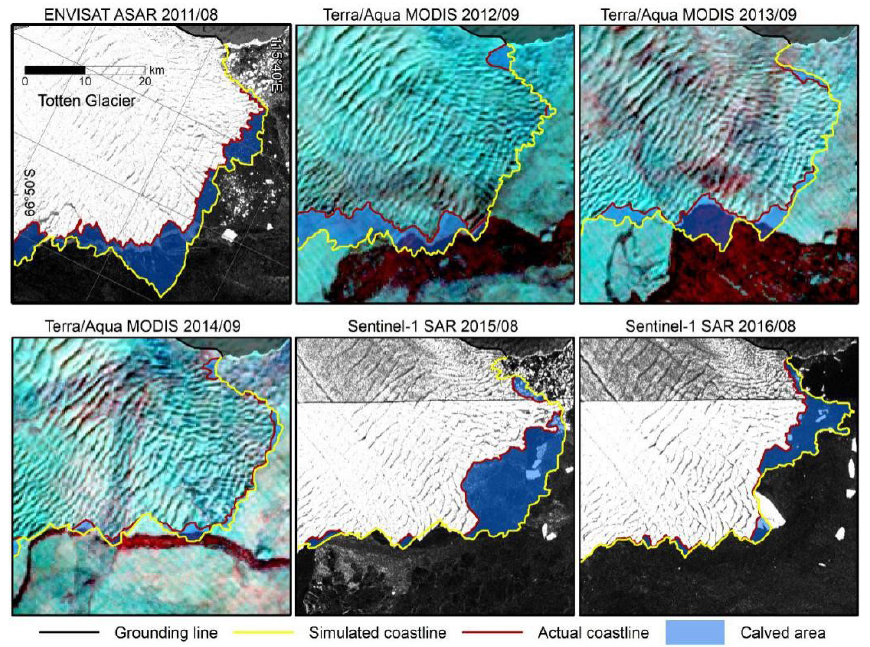
Figure 3. Schematic of the calved-area extraction method displaying different sources of satellite imagery used for annual iceberg calving extraction for 2011–2016. Red lines represent the actual coastlines, yellow lines represent the simulated coastlines, and blue areas represent the extracted calved